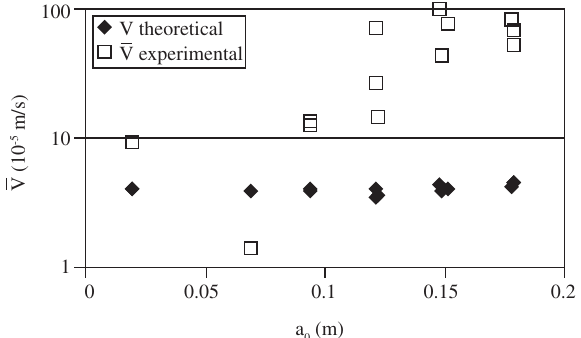
Figure 11. Examples of R-curves of test specimens with a . and 0.095 m, calculated by the LEFM a) and EM b) 0